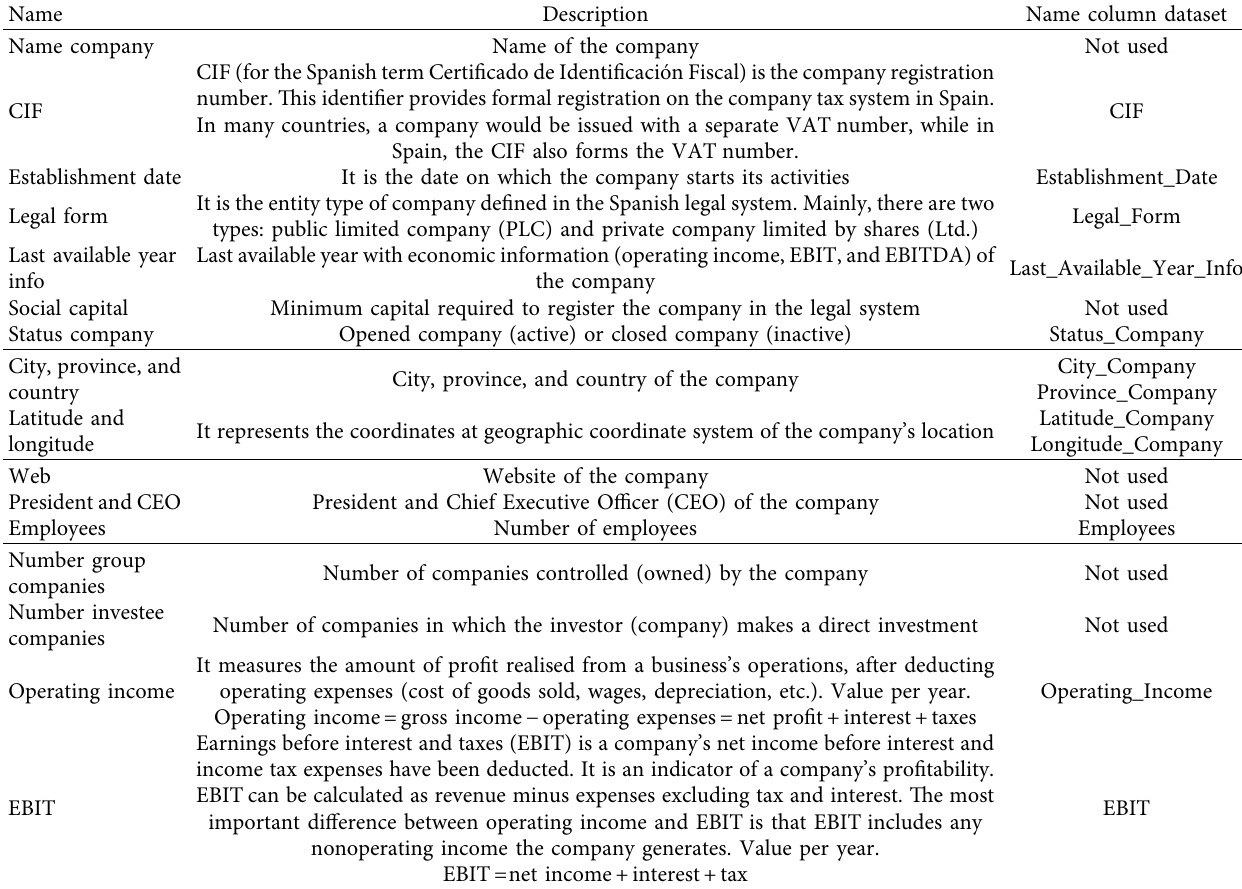
Table 2: Data fields in the company’s information